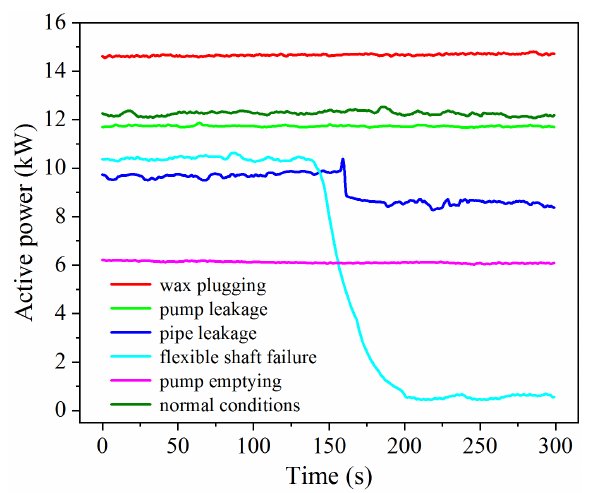
Fig. 4. Typical power diagram under six working conditions